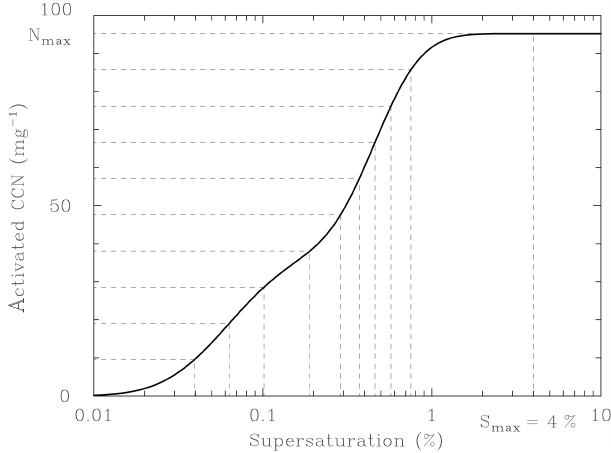
Figure 1. Thick line: number mixing ratio of activated CCN as a function of the supersaturation, the Twomey relationship, used in simulations described herein. Thin dashed lines illustrate numerical implementation of the CCN activation scheme. See text for